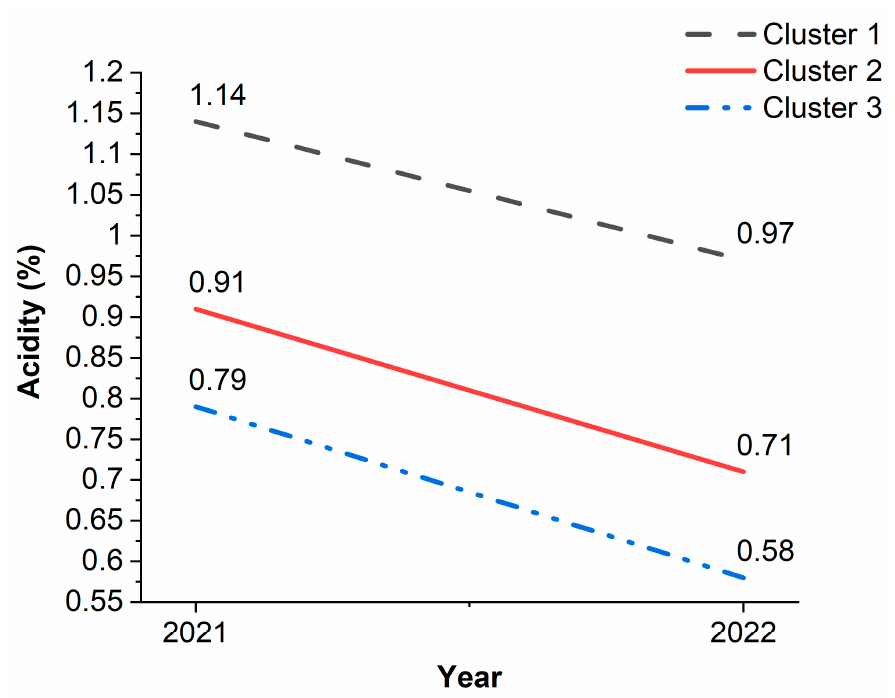
Figure 5. Grouping varieties of strawberries according to acidity % by the K-mean cluster analysis. Cluster 1 (7): ‘Dange, Earliglow’, ‘Festivalnaja’, ‘Honeoye, Redcoat’, ‘Regatt 80’, ‘Surprise des